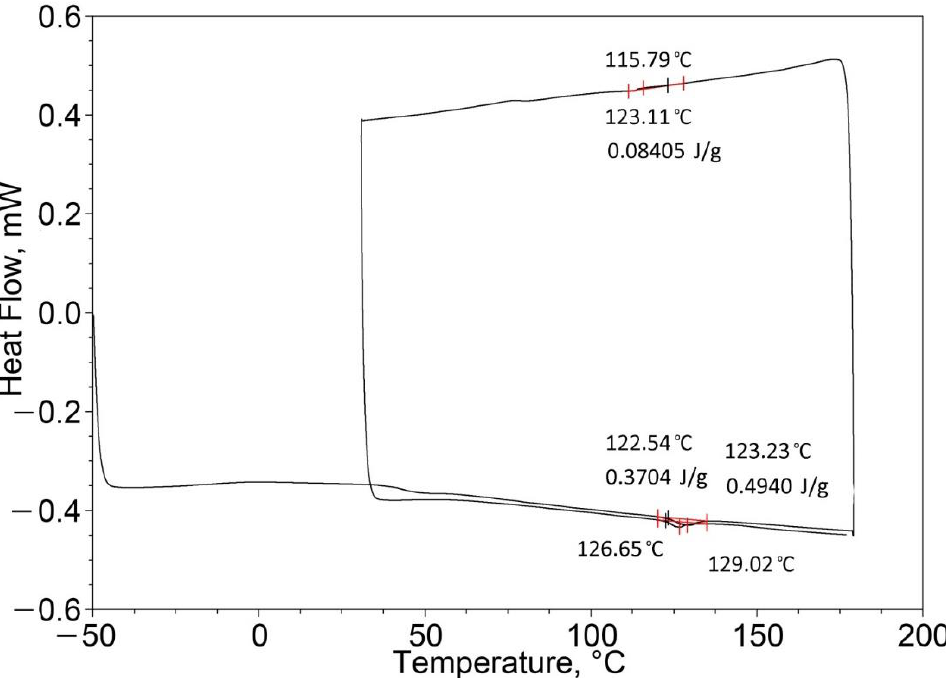
Figure 10. Melting-crystallization-melting diagram of the pure EPTSR-50 polymer sample produced with SEDS method.